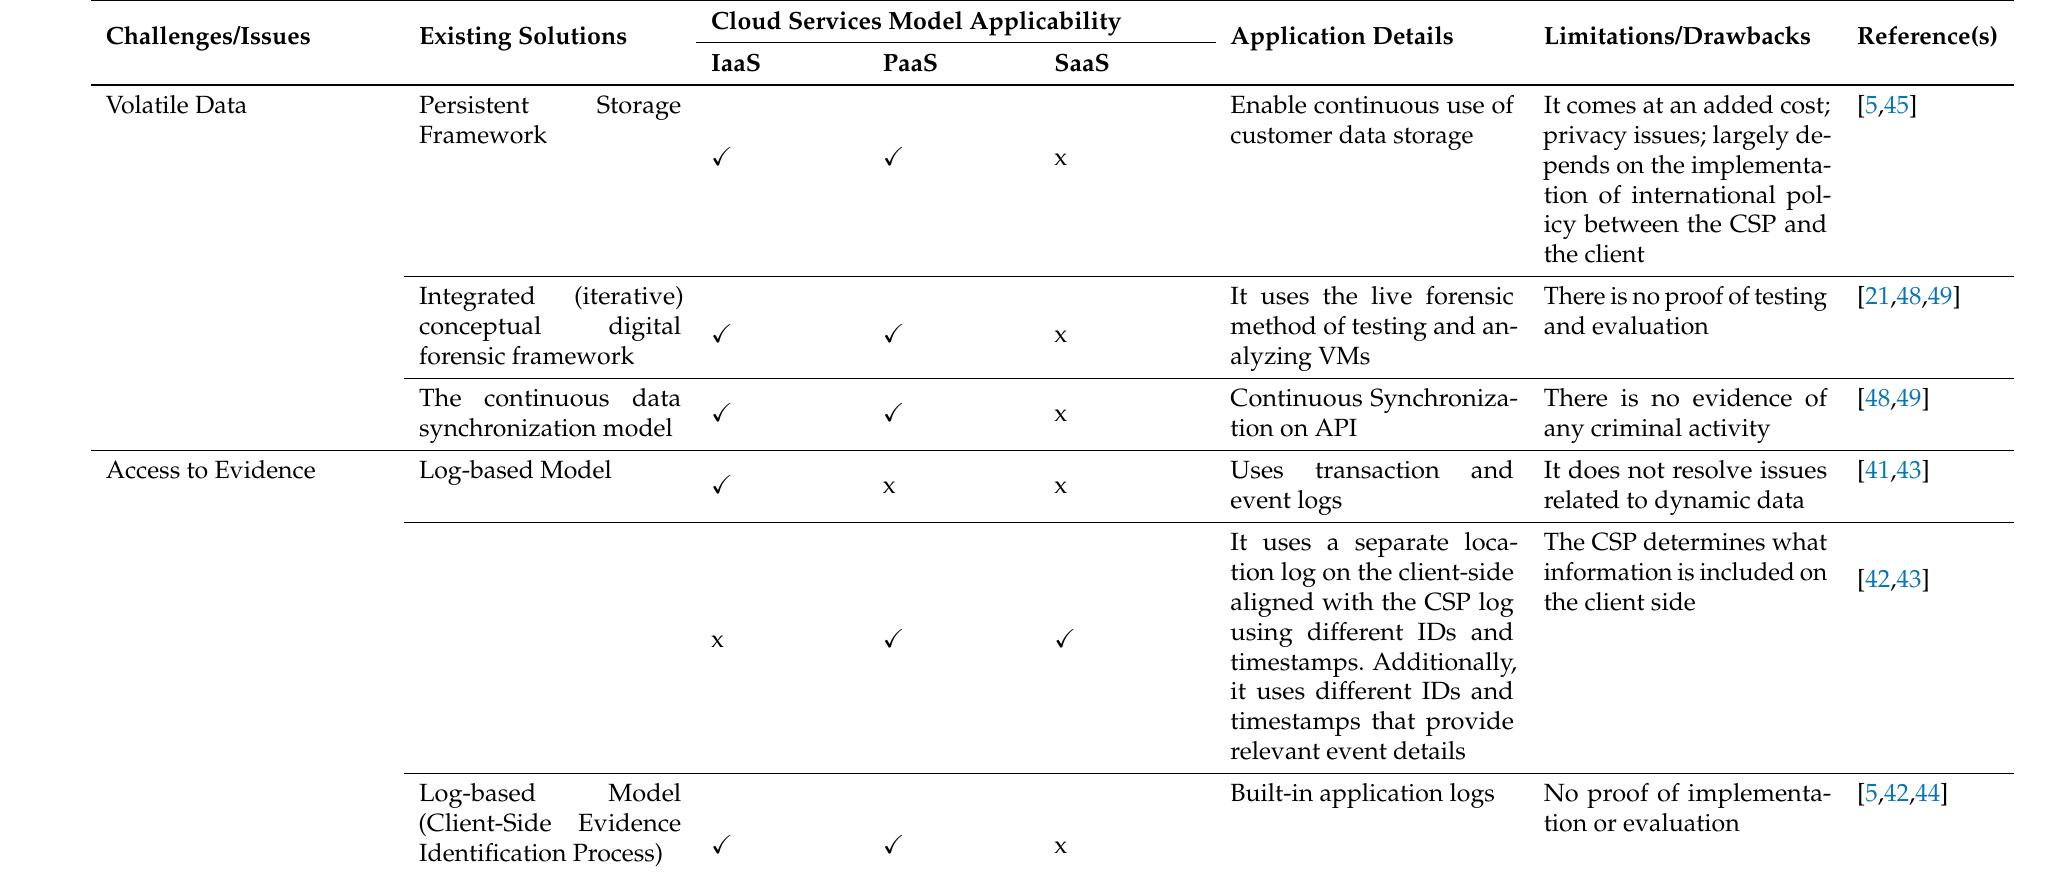
Table 1. Summary of challenges/issues and existing